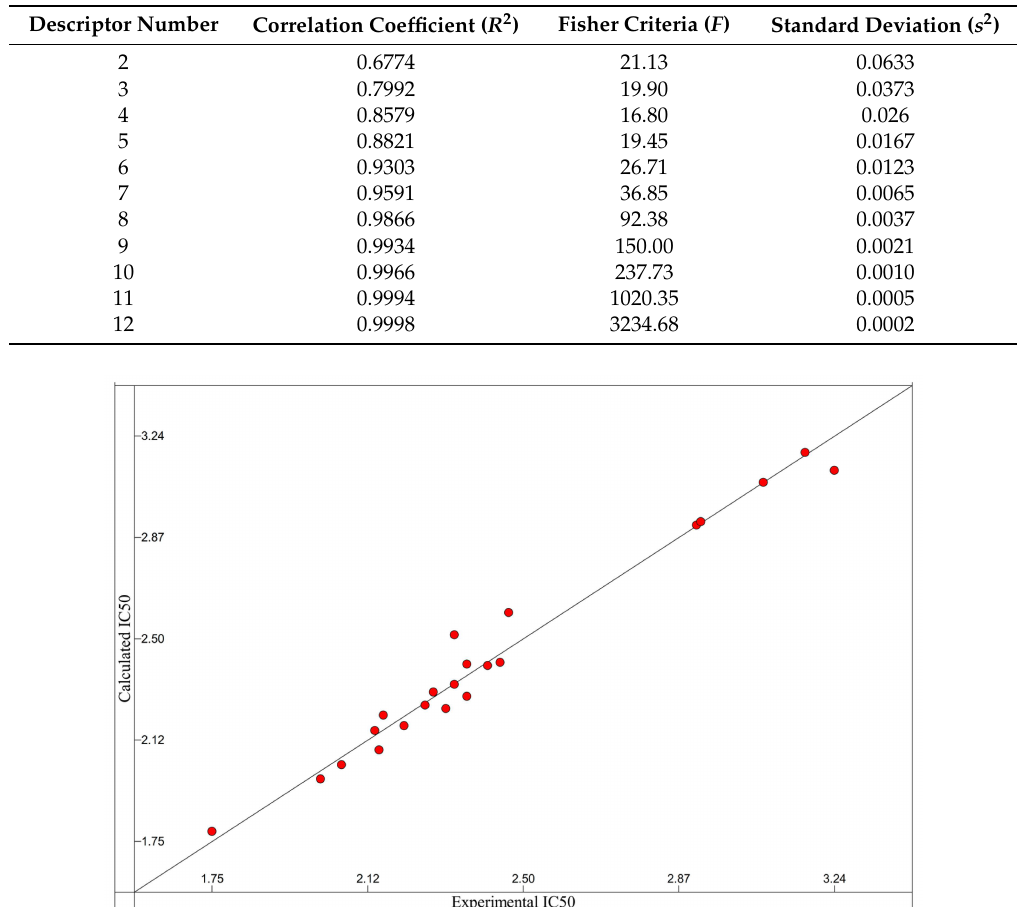
Figure 3. Comparison of the experimental hyaluronidase activity with the activity presented by the QSAR Equation (1), n = 20, with R 2 = 0.8579; s 2 = 0.0246; F = 21.13; four